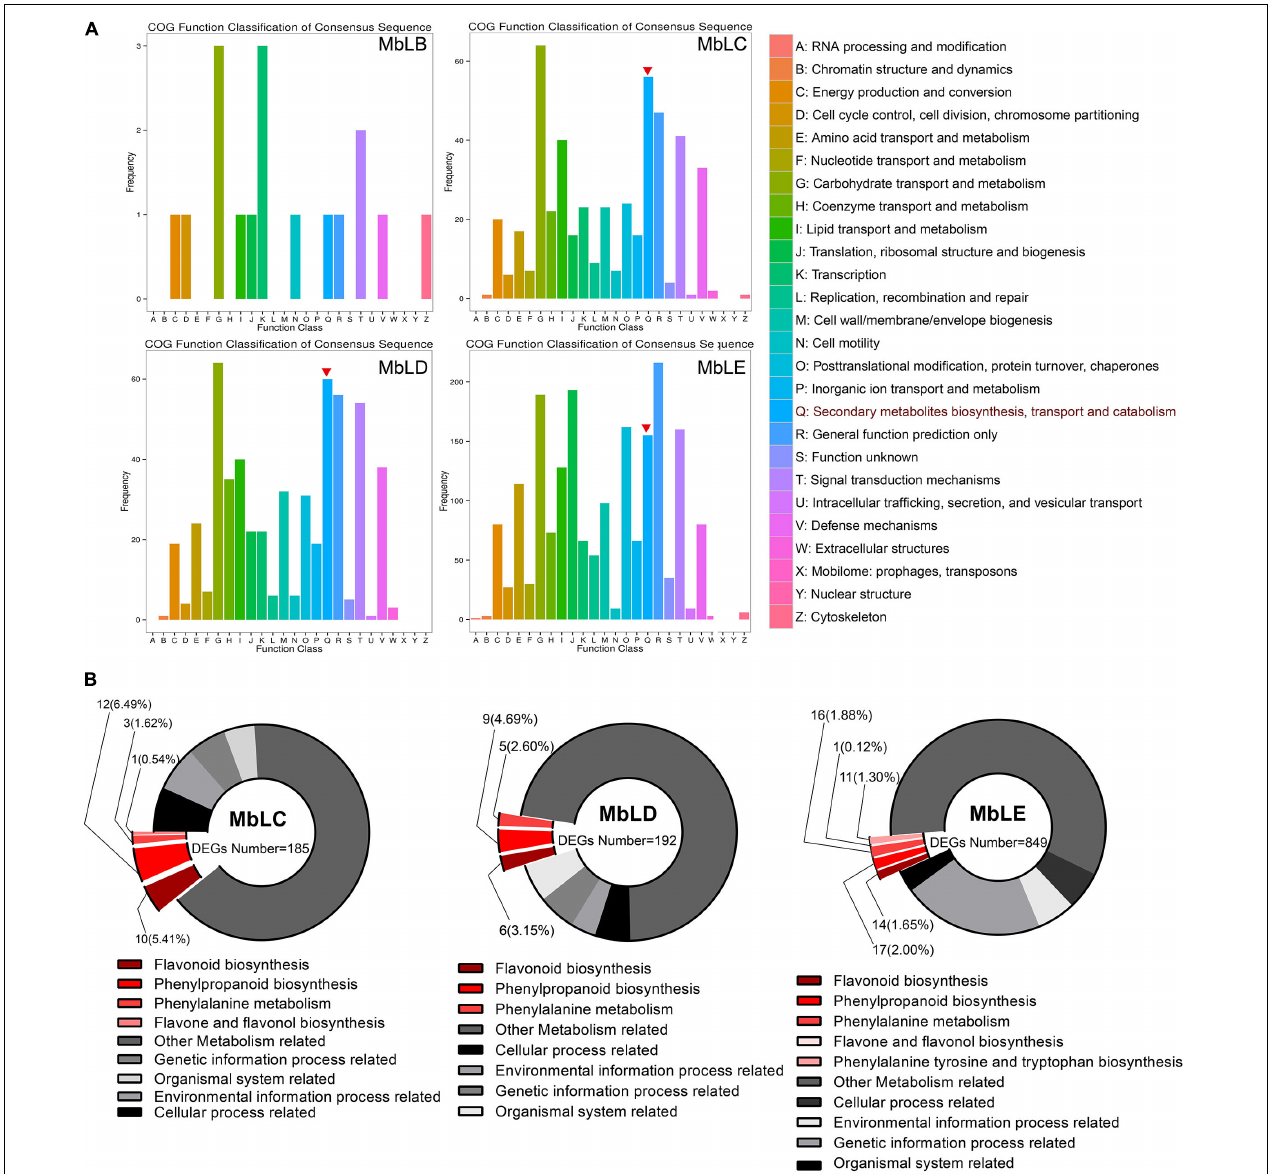
FIGURE 4 | Rich distribution map of differentially expressed genes based on functional annotation. (A) COG function classification. The vertical axis represents the gene frequency, and the horizontal axis represents the function class. The red inverted triangles indicated the genes involved in secondary metabolites biosynthesis, transport, and catabolism. (B) The enrichment factor represents the ratio of the genes’ proportion annotated to a certain pathway in different genes to the genes’ proportion annotated to this pathway in all genes. The circle’s color represents the Q -value, which is the P -value after the correction of multiple hypothesis tests. The smaller the Q value, the more reliable the enrichment significance of differentially expressed genes in this pathway. The circle’s size indicates the genes’ number enriched in the pathway, and the larger the circle, the more the number of